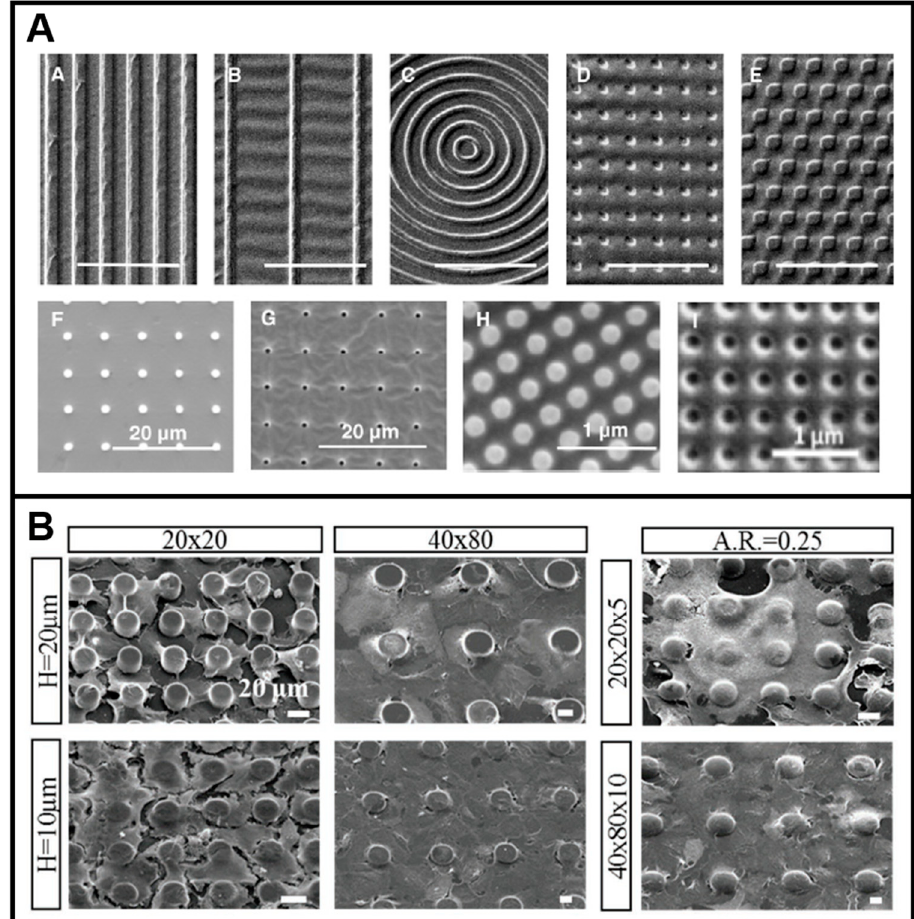
Figure 5. Examples of substrate topographies used for the culture of hCECs. Nanopillars ( E , F , H in top image) and nanowells ( D , G , E , I in top image) were demonstrated to better induce hCECs expansion and maintenance of their phenotype compared to other topographies ( A – C in top image) ( A ), while patterns with larger dimensions can be used for modelling disease of hCECs such as Fuch’s endothelial dystrophy ( B ). Scale bars: 20 µ m unless specified. Reproduced from [77] ( A ) and [80] ( B